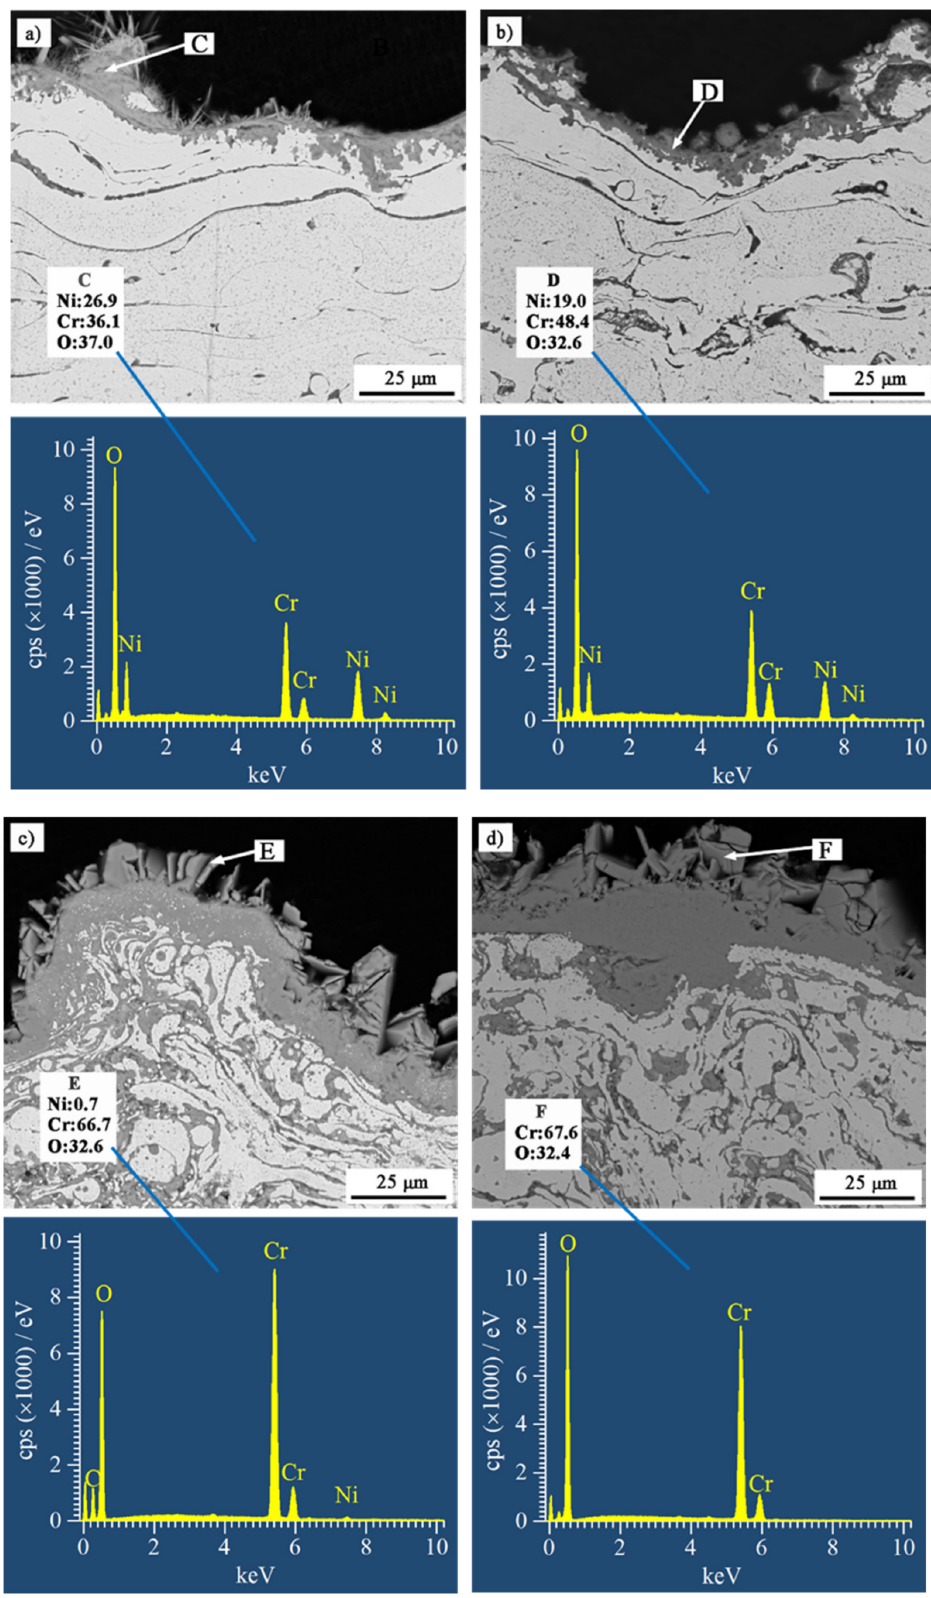
Figure 7. BSE SEM images of cross-sections of ( a ) NiCrB-Air, ( b ) NiCrB-N 2 , ( c ) NiCrTi-Air, and ( d ) NiCrTi-N 2 coatings after the hot corrosion test, corresponding with the EDS results of the corro- sion